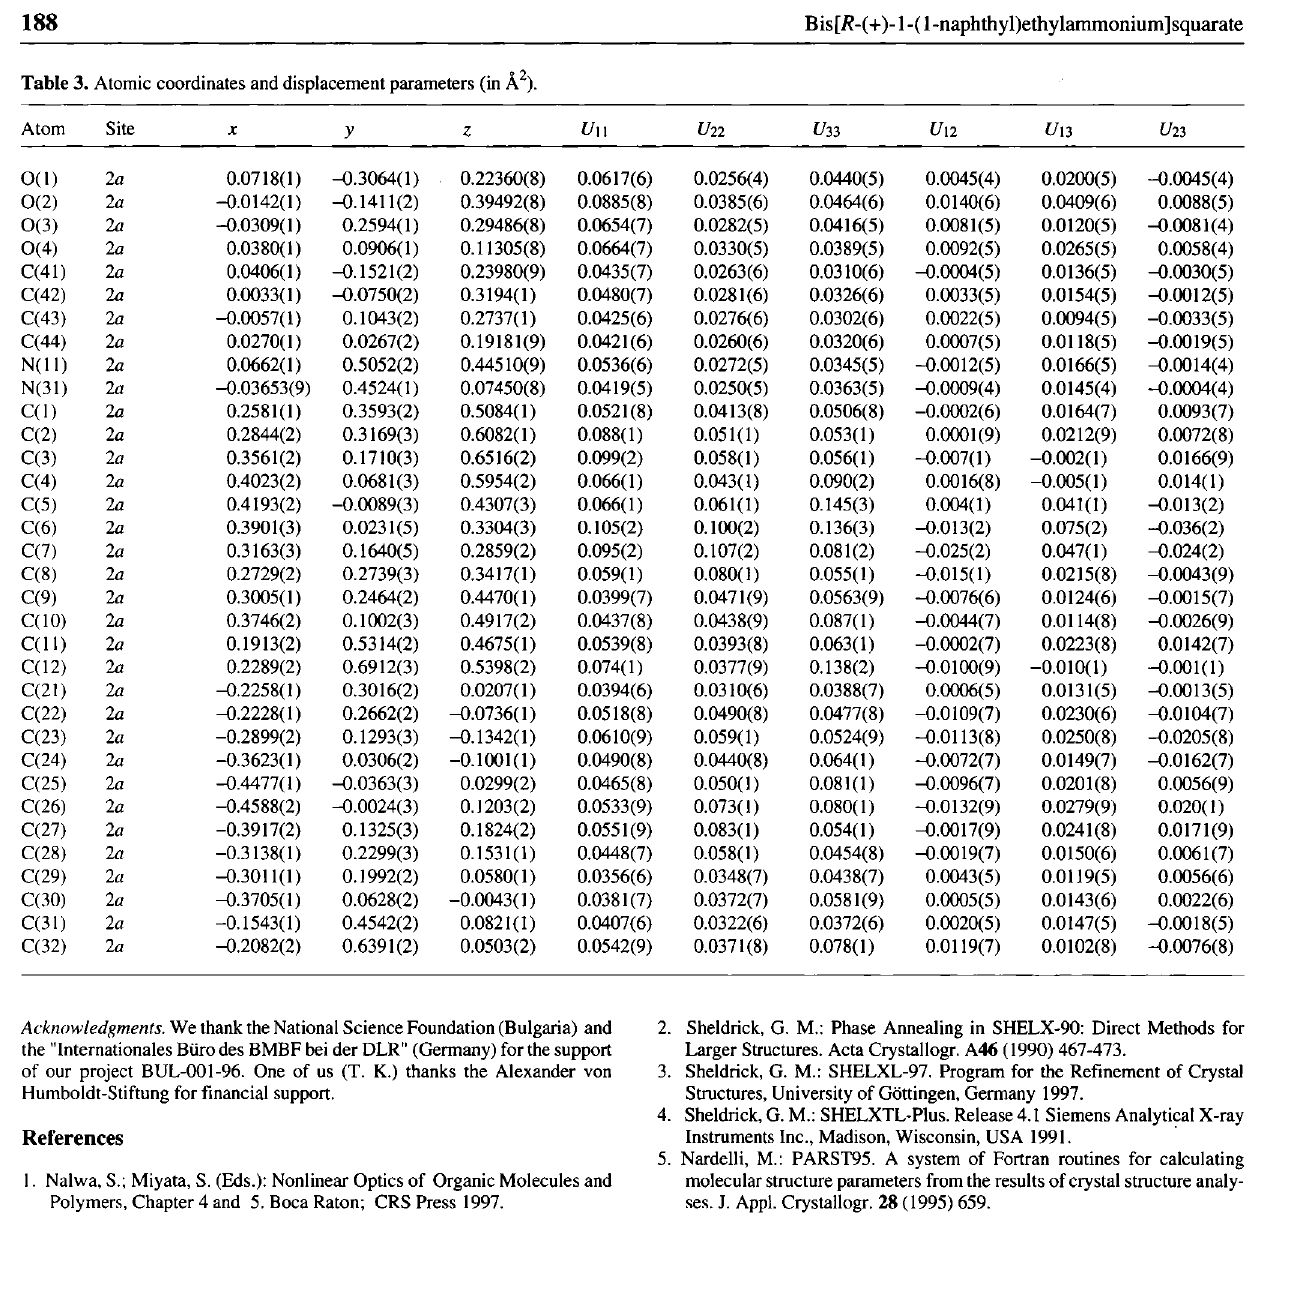
Table 3. Atomic coordinates and displacement parameters (in Ä 2